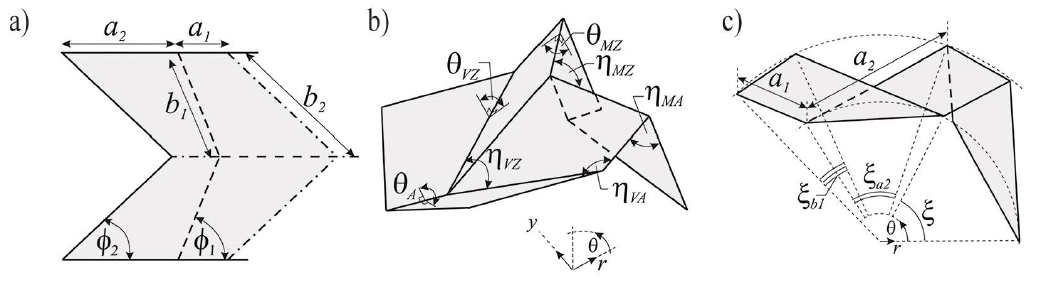
Figure 6: Arc-miura CP unit: a) unfolded, b) half-folded and c) fully folded [20]